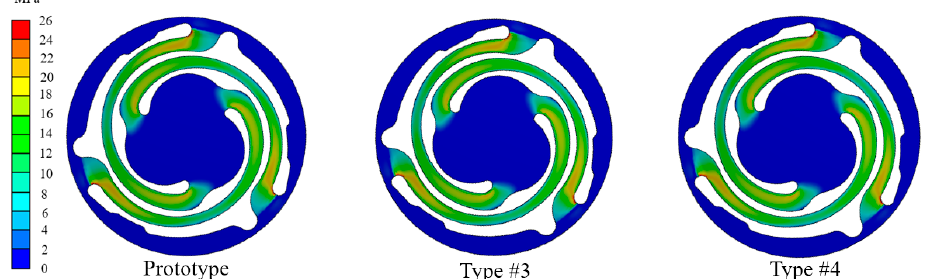
Figure 18. von Mises stress distribution on spring with different round #1 parameters. Table 3. Analysis result comparison between different round #1 parameters.